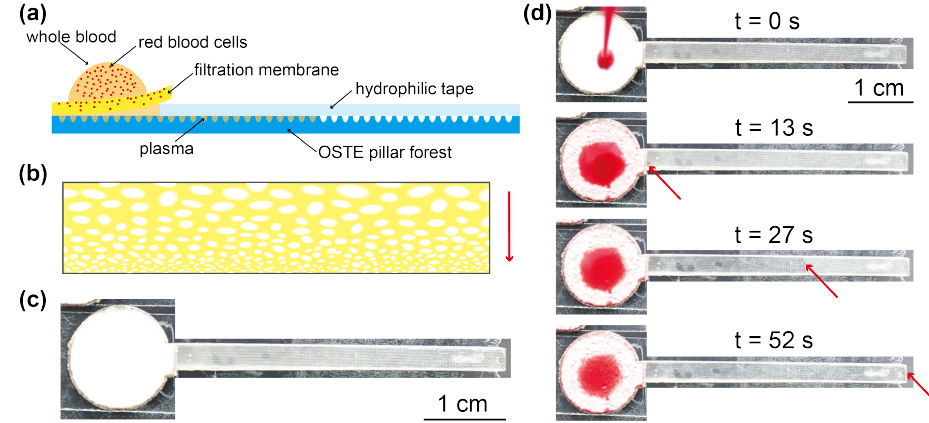
Figure 2. Design of the passive microfluidic device and experiments of plasma separation on the device. ( a ) The schematic of cross section of the device. Part of the OSTE pillar forest substrate is covered by the hydrophilic tape, and part of the OSTE pillar forest substrate is covered by the filtration membrane. There is a void region with a wedge shape between the filtration membrane, hydrophilic tape, and OSTE pillar forest. ( b ) The microstructure of filtration membrane (not to scale). The pore size on one side of the membrane is bigger than that on the other side (contacting OSTE pillar forest substrate); the red arrow indicates the direction of blood flow. ( c ) A real device. ( d ) The whole process of plasma separation on a device: we loaded 45 µ L of whole blood on the center of the filtration membrane; then, we found that plasma appeared in the region under the hydrophilic tape. After that, plasma continued pumping out until the OSTE pillar forest substrate was filled with plasma. The red arrows indicate the position of the plasma